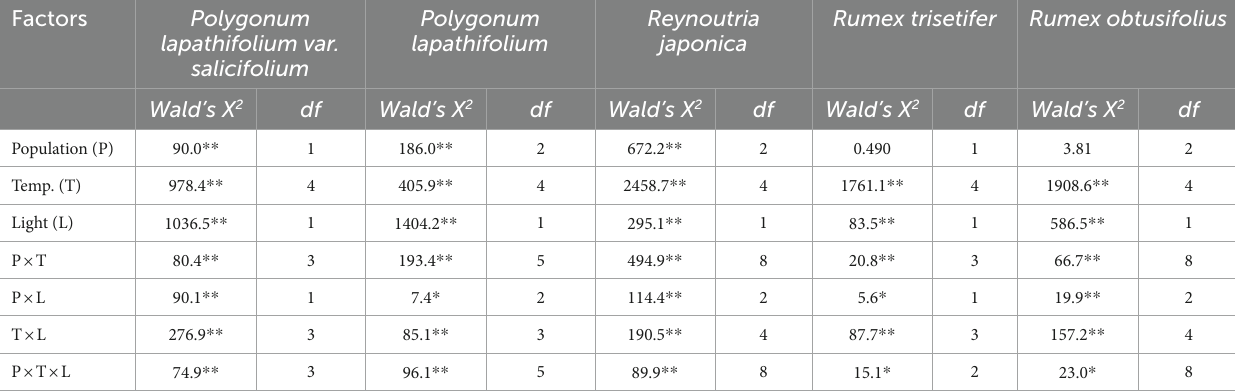
TABLE 3 Effect of population (P), incubation temperature (T), and photoperiod (L) on seed germination percentage of five Polygonaceae species. Factors Polygonum lapathifolium